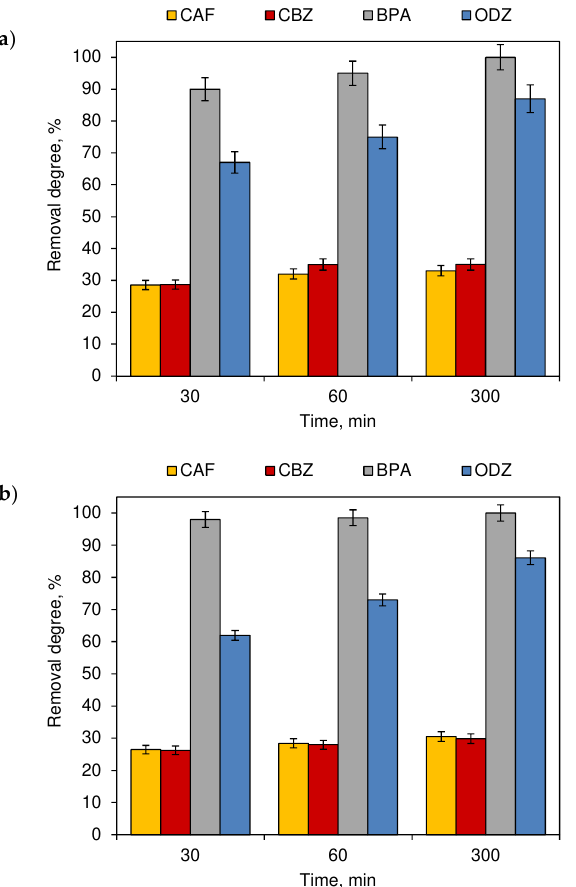
Figure 7. The removal degree of CECs from chlorinated model swimming pool water additionally irradiated by UV light—( a ) outdoor swimming pool and ( b ) indoor swimming pool ( n = 3; where CAF—caffeine, CBZ—carbamazepine, BPA—bisphenol A, ODZ—oxadiazon).